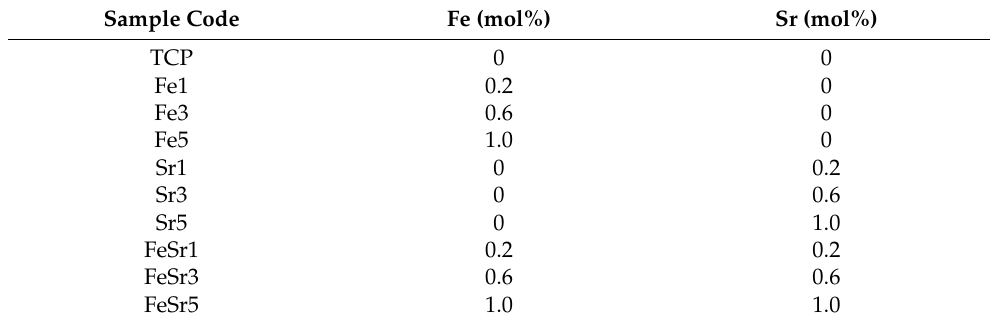
Table 1. Sample notation and the concentration of chemical reagents for preparation of different β -TCP